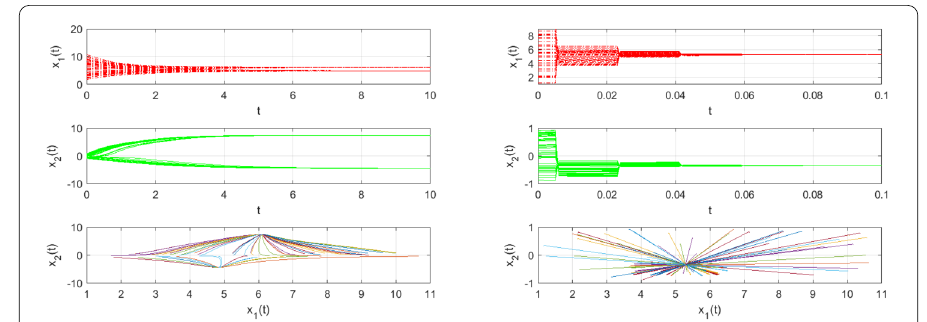
Figure 6 Transient behavior and state trajectories of x 1 and x 2 near the equilibrium point x (6) = (5.2870,–0.3416) T without impulsive input in the left graphs, and with impulsive input in the right